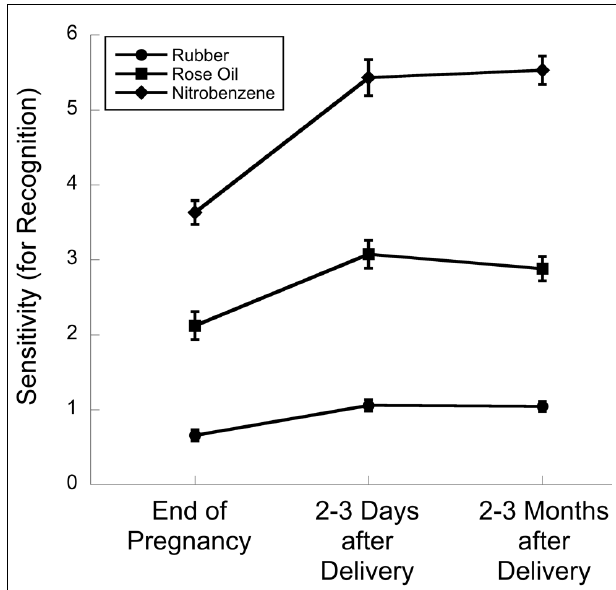
FIGURE 2 | Data from Hansen and Glass (1936). Sensitivity (inverse of threshold) for recognition for each of three odors, plotted for the end of pregnancy and two postpartum test sessions. Zwaardemaker olfactometer was used to measure thresholds of 22 participants who were followed longitudinally.